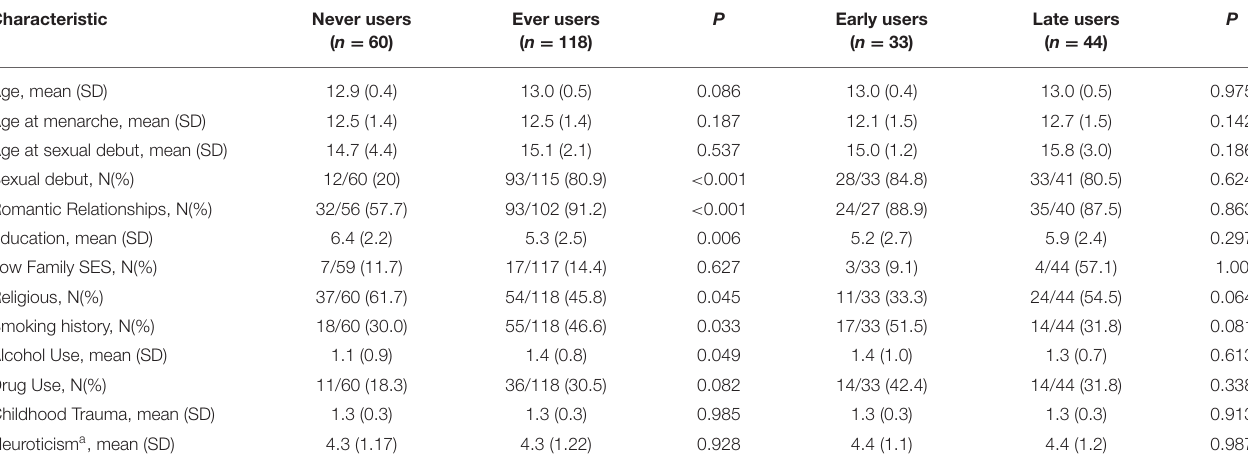
TABLE 1 | Study sample characteristics depending on history of oral contraceptive use.